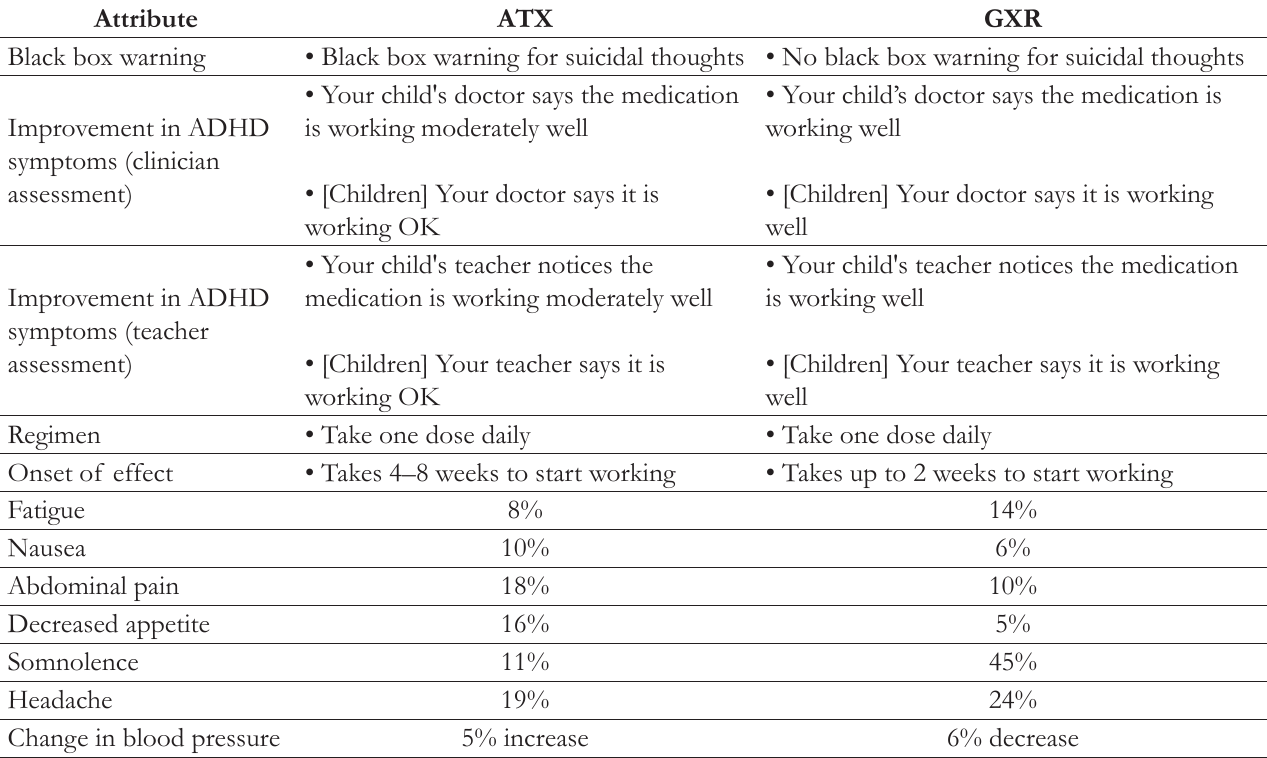
Table 1. Summary of Base-case